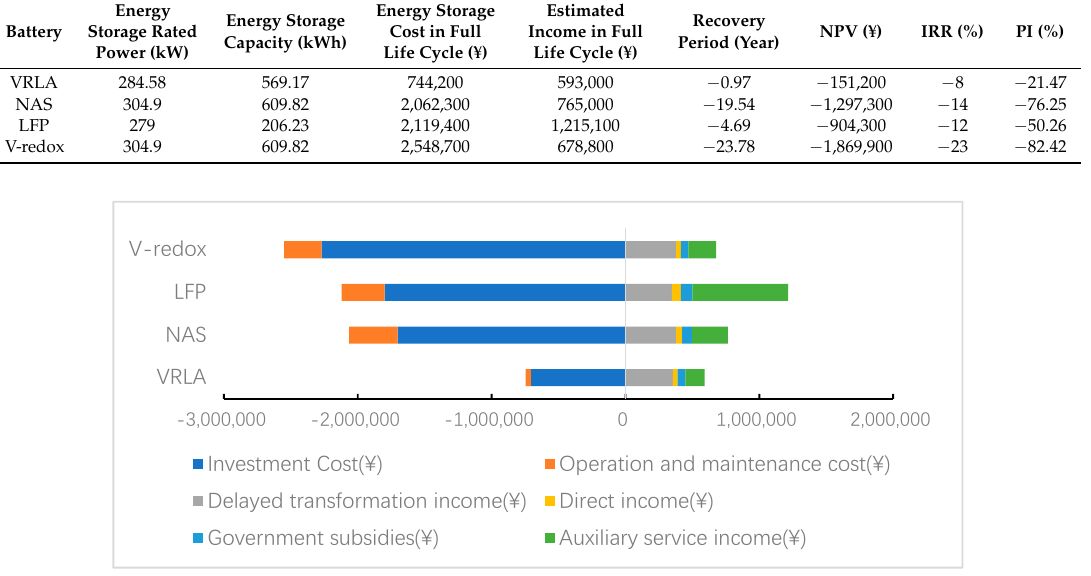
Figure 5. Each cost and income term of four different energy storage batteries for peak shaving.